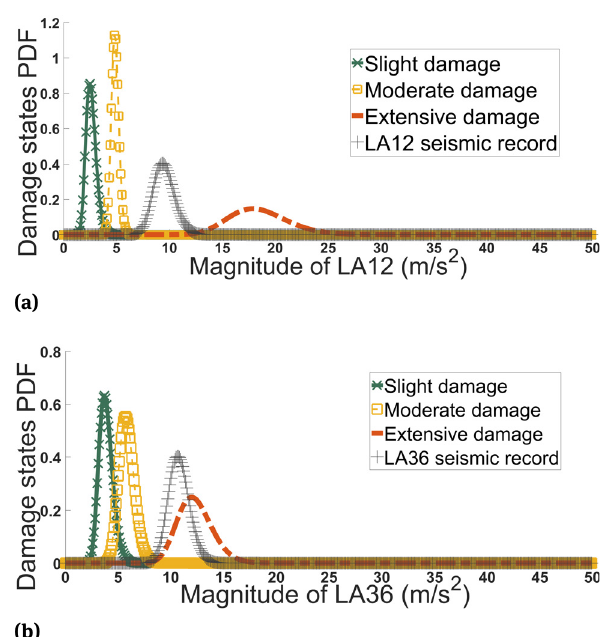
Figure 14: Probability of being in or exceeding damage states of the three-story optimized frame subjected to, (a). LA12 and (b) LA36 seismic